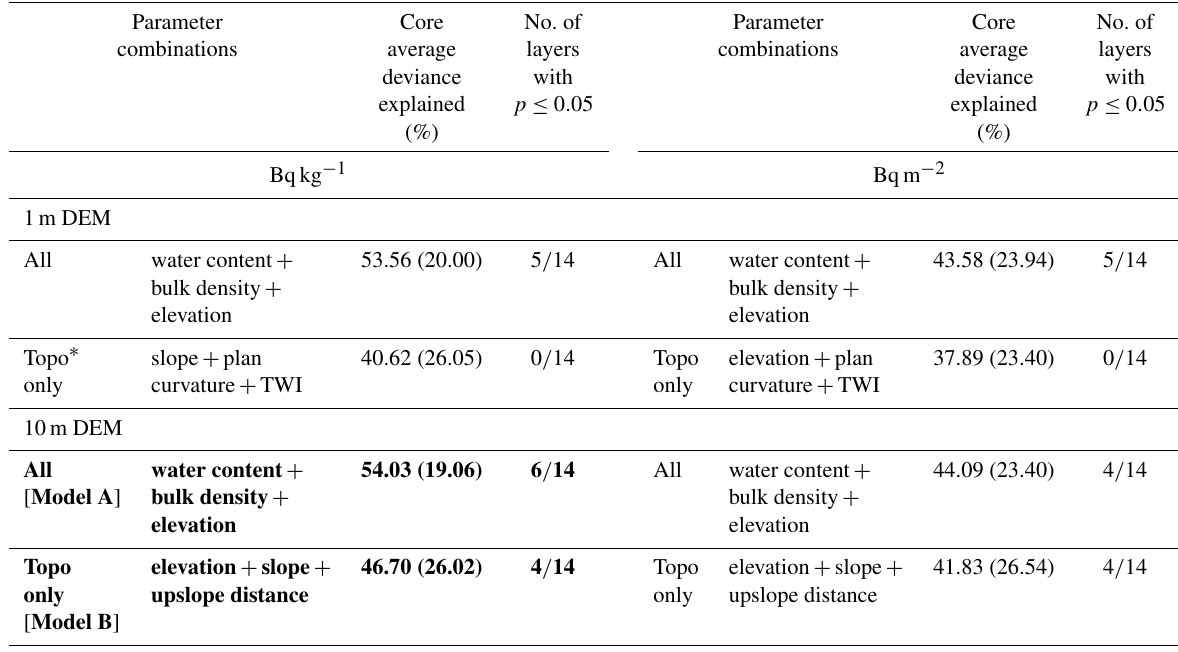
Table 6. The most effective parameter combinations with the best deviance-explained percentages and the number of depth layers where p values were equal to or less than 0.05. “()” indicates standard deviation. The two models given in bold, [A] and [B], returned the best model performance with the 10m DEM and were used for reverse prediction accuracy checks.